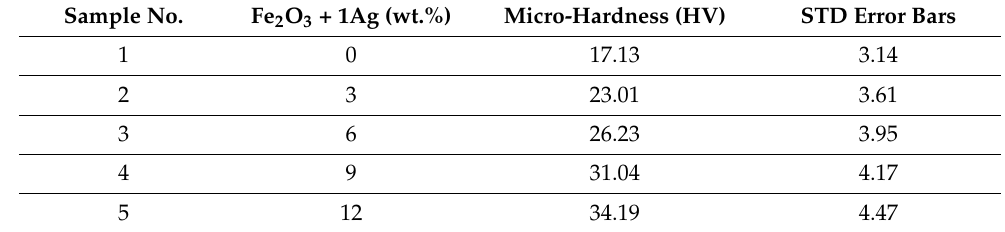
Table 1. Micro ‐ hardness values of the samples of Al/Fe 2 O 3 + 1 wt.%Ag. Sample No. Table 1. Micro-hardness values of the samples of Al/Fe 2 O 3 + 1 wt.%Ag. Sample No.